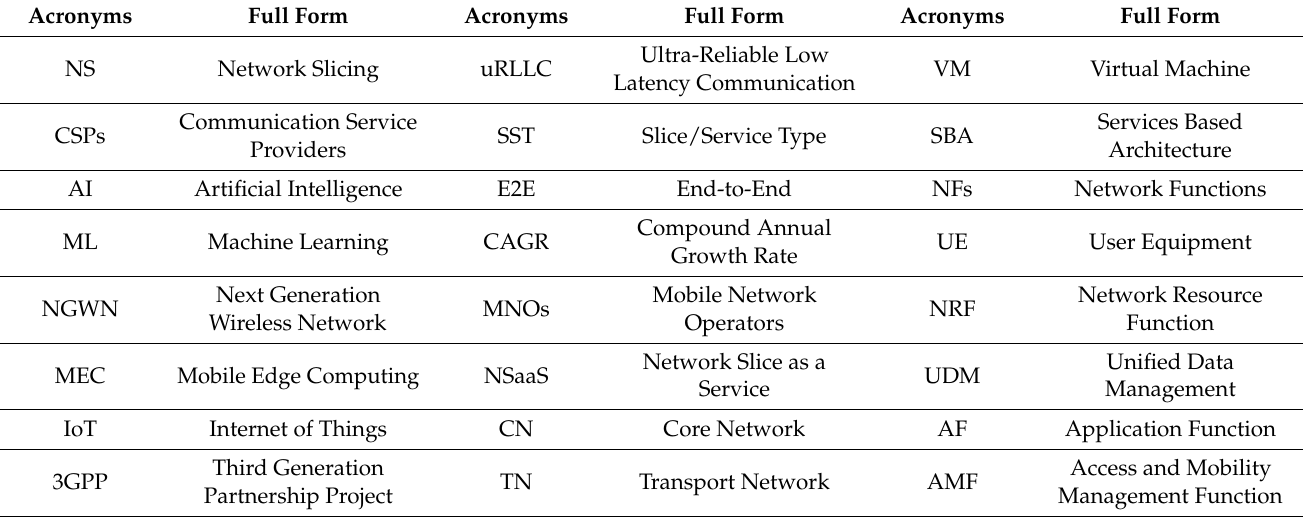
Table 3. Summary of